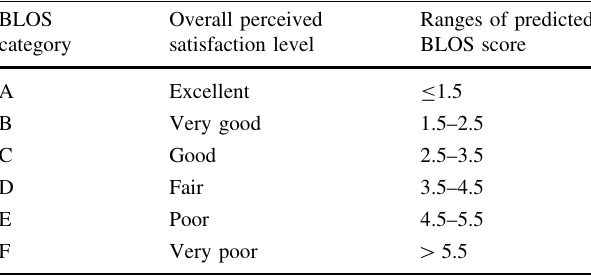
Table 7 BLOS score ranges of service categories (A–F)